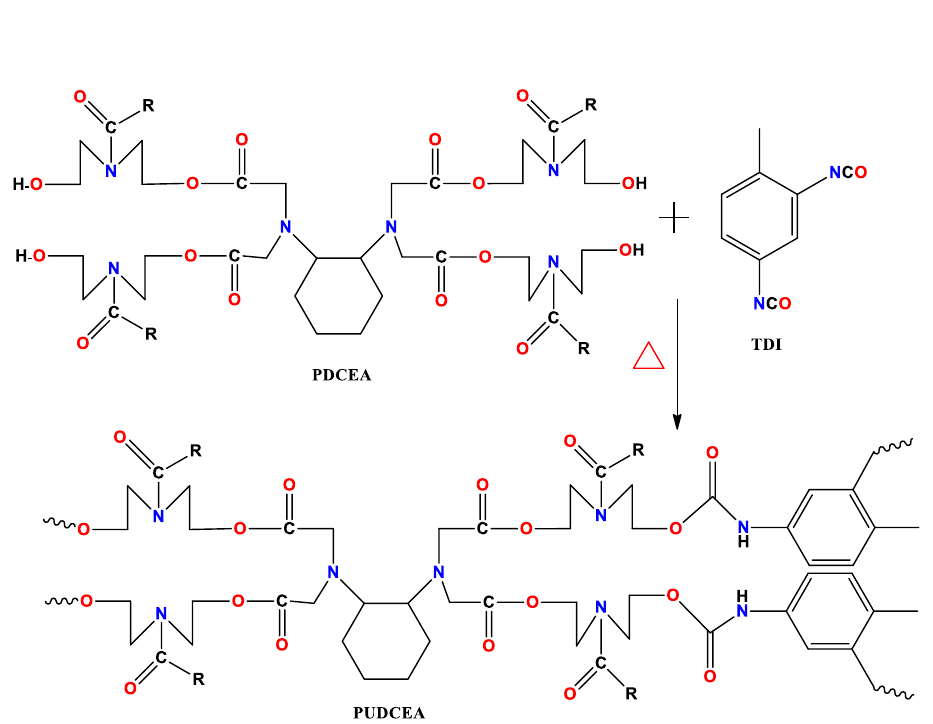
Scheme 1 : Synthesis of PDCEA.